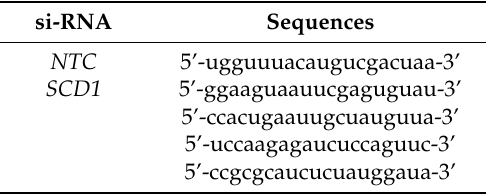
Table 1. siRNA sequences used in this